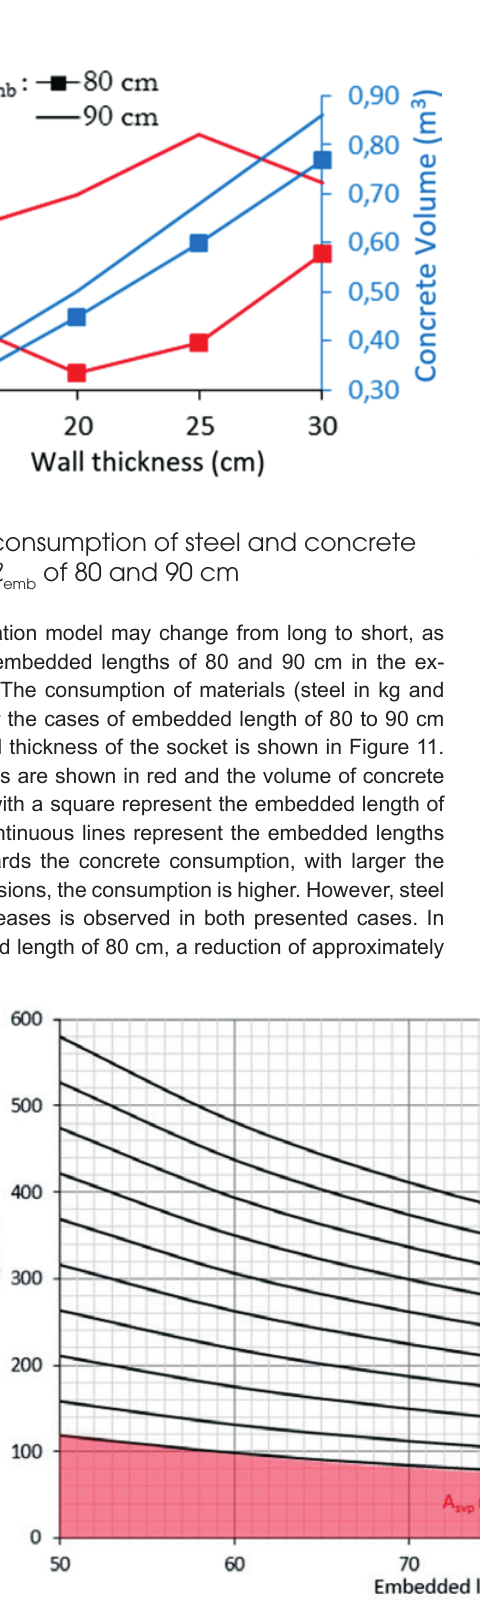
Abacus for calculating the main vertical reinforcement (cm 2 ) for a C25 concrete and a CA-50